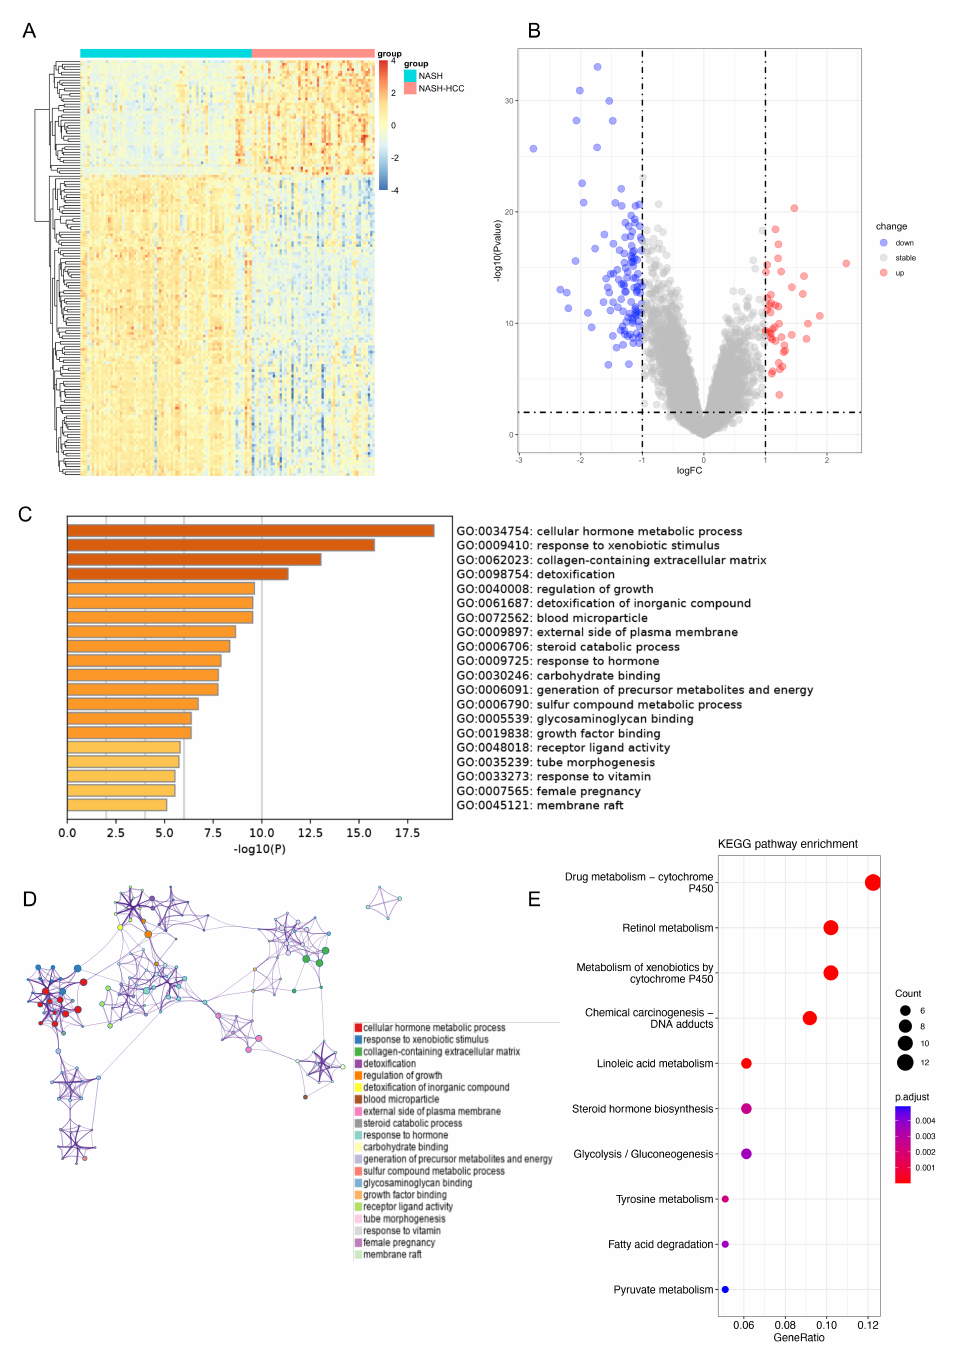
Figure 1. Gene expression and enrichment analysis revealed DEGs in NASH-HCC tissues and their association with the process of material metabolism and regulation of growth. (A) Heatmap of all DEGs in NASH tissues and NASH-HCC tissues. (B) Volcano map of all DEGs when comparing NASH-HCC tissues to NASH tissues. Red indicates upregulated genes, blue represents downregulated genes, and grey means genes that were not differentially expressed. (C) Heatmap of GO enrichment terms of DEGs in Metascape, colored by P -value. (D) Network of GO enrichment terms, colored by cluster ID. (E) The dot plot of the top 10 terms of KEGG enrichment analysis. DEG, differentially expressed genes; GO, Gene Ontology; HCC, hepatocellular carcinoma; KEGG, Kyoto Encyclopedia of Genes and Genomes; NASH, non- alcoholic